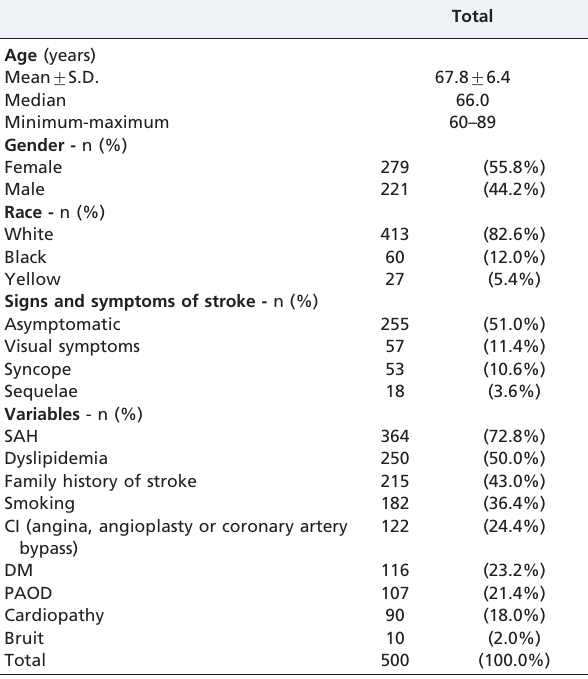
Table 1 - Characterization of a sample of 500 participants in the Stroke Prevention Campaign who underwent carotid stenosis